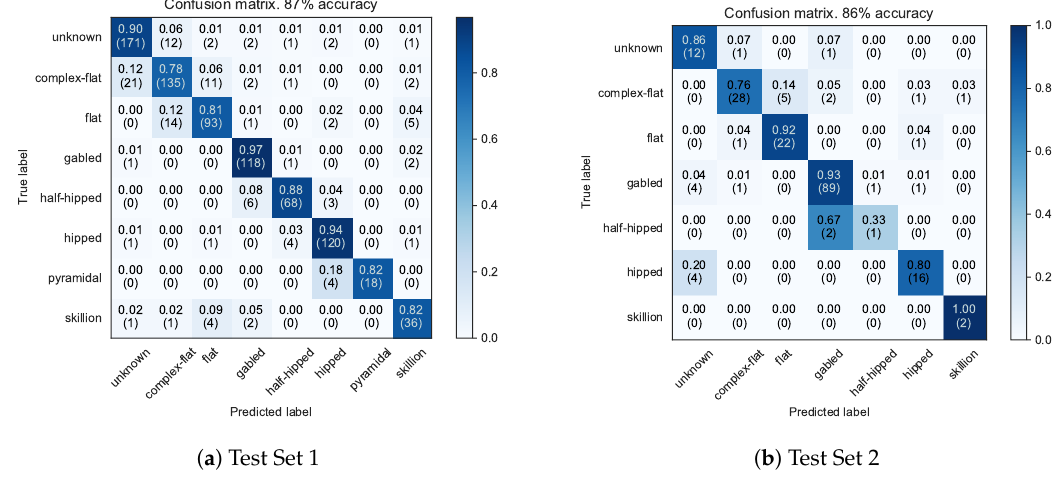
Figure 13. Confusion Matrices for Test Set 1 (Witten/Manhattan) and Test set 2 (Ann